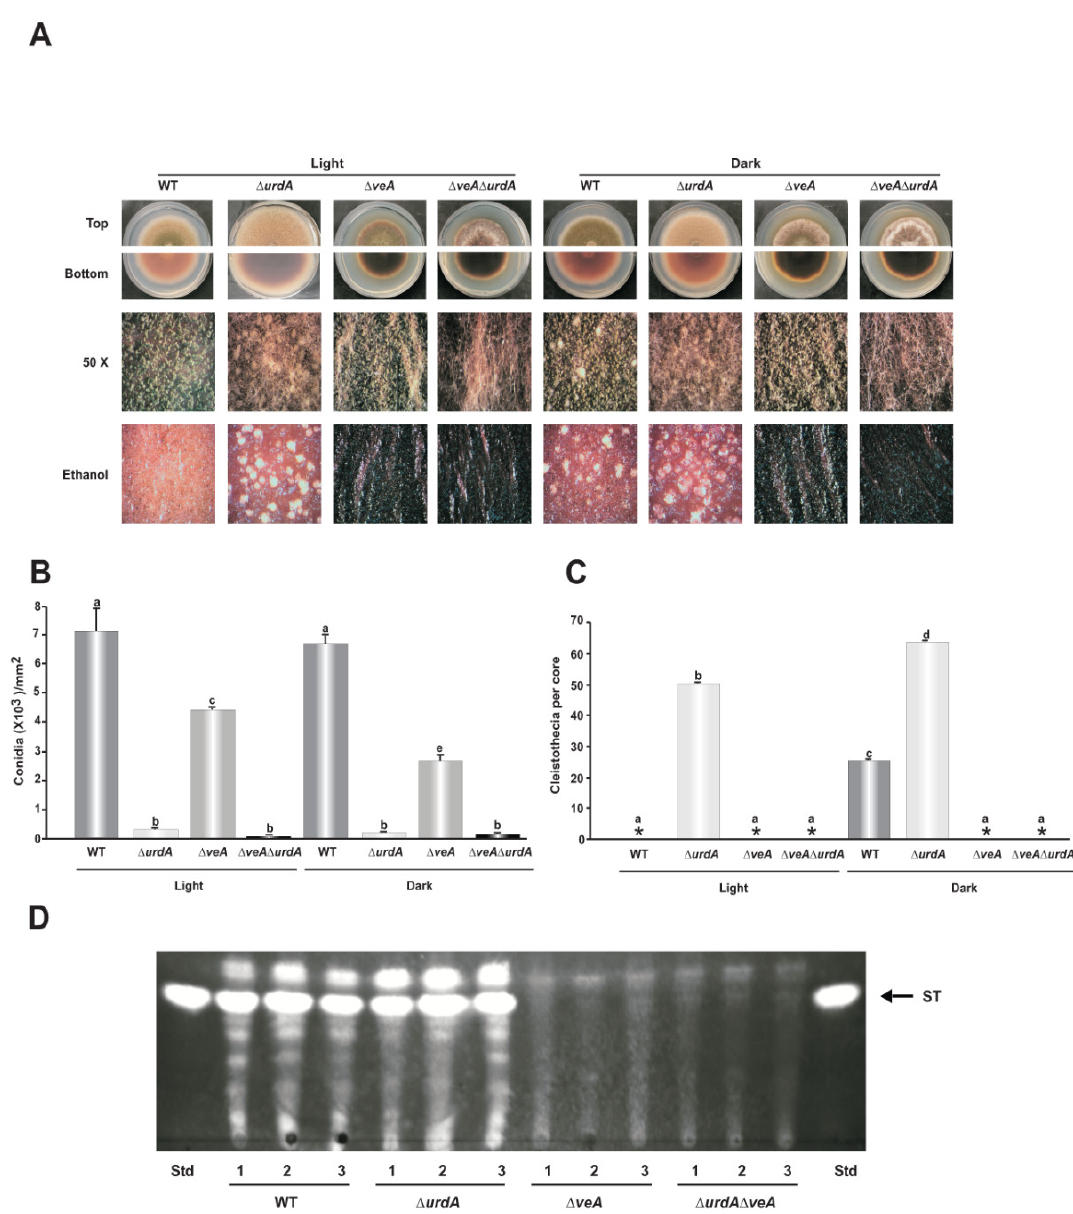
Figure 9. Epistatic relation between veA and urdA . ( A ) Wild type, Δ urdA , Δ veA and Δ veA Δ urdA were point‐inoculated and cultivated in dark and light conditions for 6 days. Micrographs were taken with a Leica MZ75 dissecting microscope attached to a Leica DC50LP camera at 50× magnification. ( B ) Quantification of conidiospores as described in Material and Methods ( C ) Quantification of cleistothecia after spraying the plates with 70% ethanol to enhance visualization. ( D ) TLC analysis of ST. Cores (16 mm) were collected 1.5 cm from the center of the colony after 6 days and ST was extracted as described in Material and Methods. Asterisks indicate not detected. Std., Standard. Values are means of three replicates and error bars indicate standard errors. Different letters above the bar graphs represent significantly different values ( p ≤ 0.05).